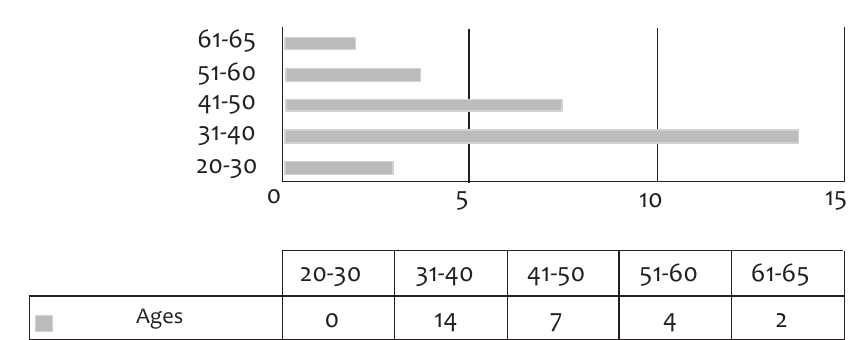
Figure 3: Teachers’